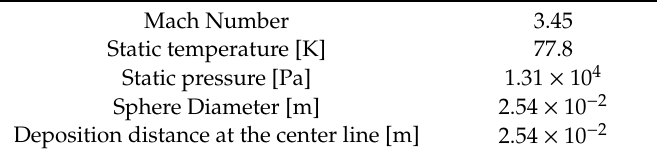
Table 1. Flow conditions in the wind tunnel test